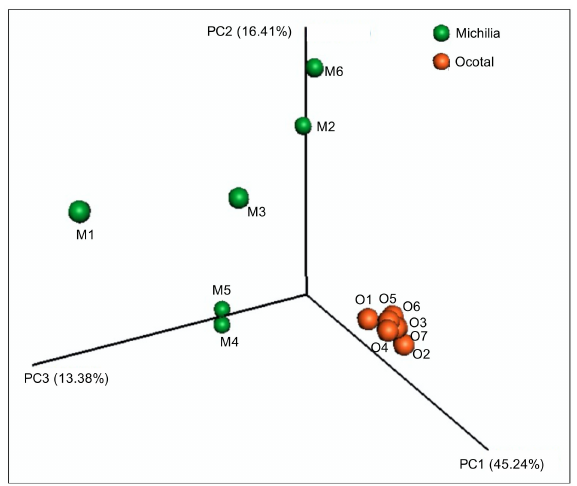
Figure 2. Principal Coordinate Analysis (PCoA) plot based on Bray–Curtis index of the fecal bacterial microbiota from two populations of Mexican wolves (Canis lupus baileyi) in Michilia (M, 23 ◦ N) and Ocotal (O, 19 ◦ N),